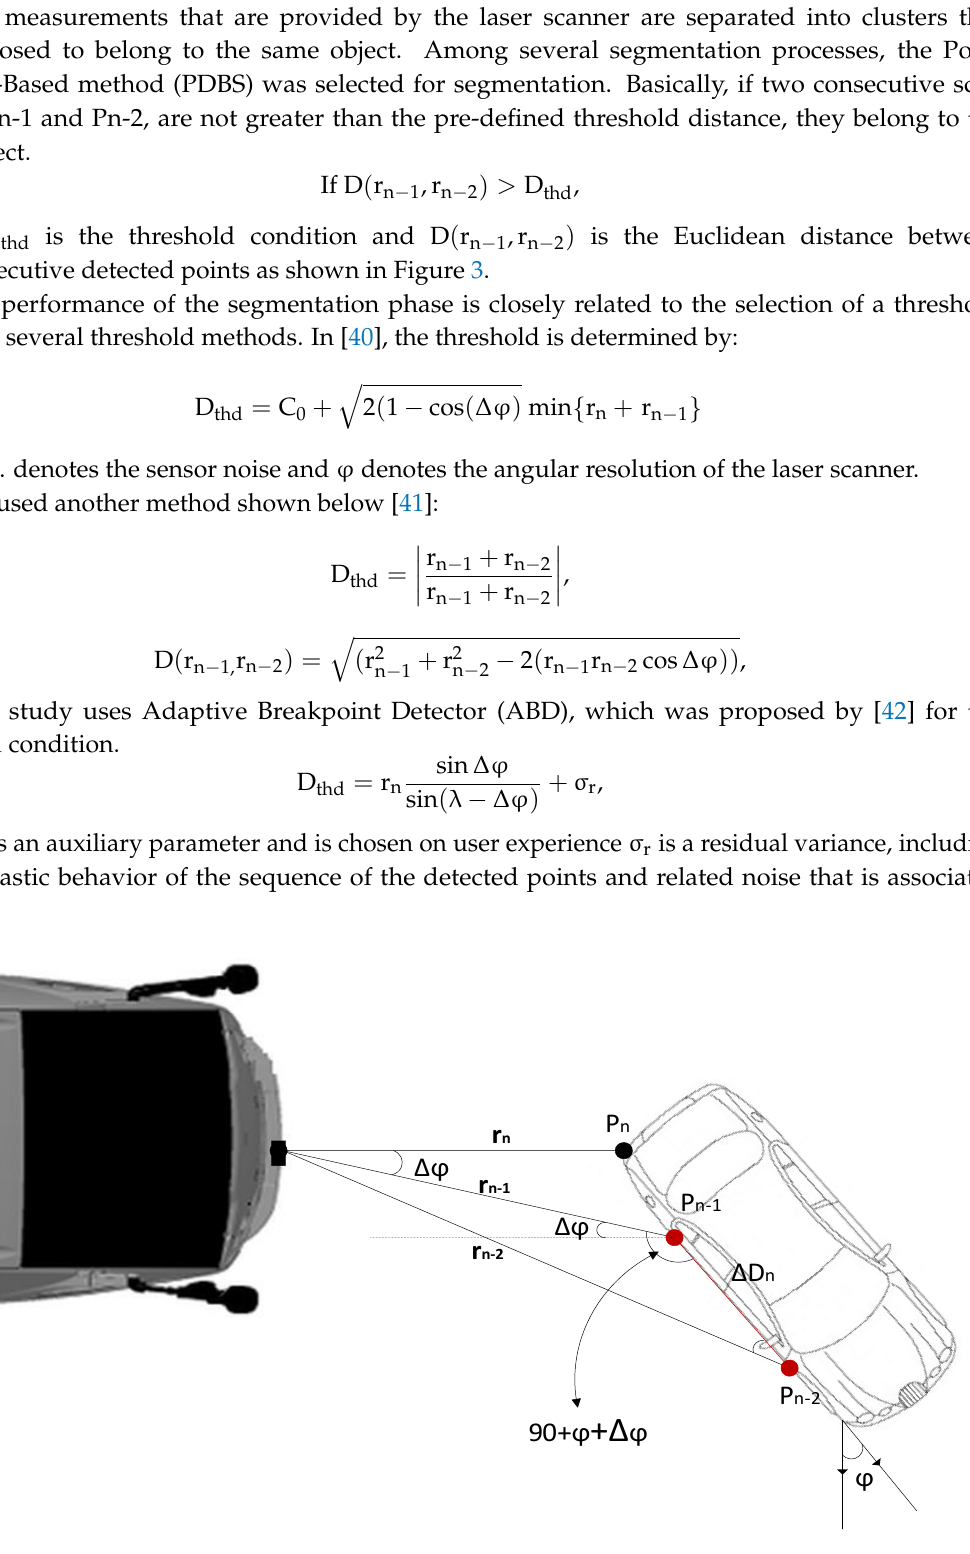
Figure 3. The distance between the consecutive scanned points of the object in front of the tram. Before and after segmentation process outputs can be seen Figure 4.